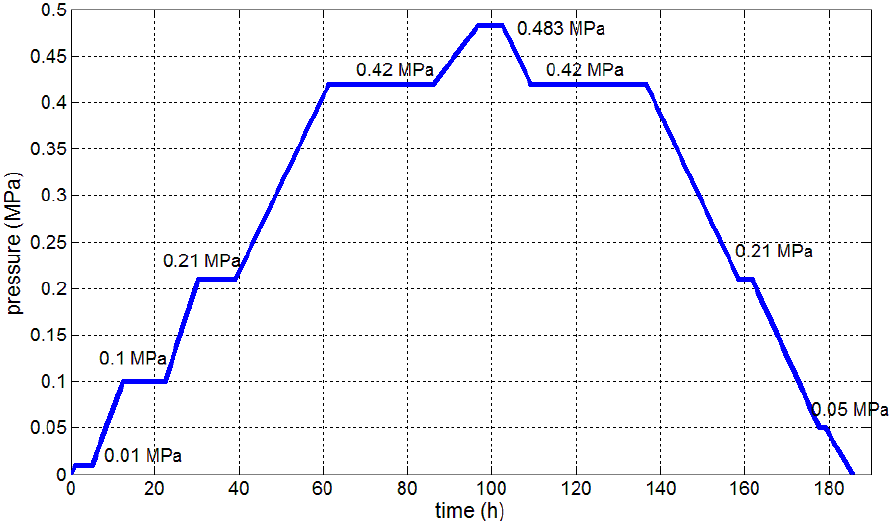
Figure 4. The pressure time table.